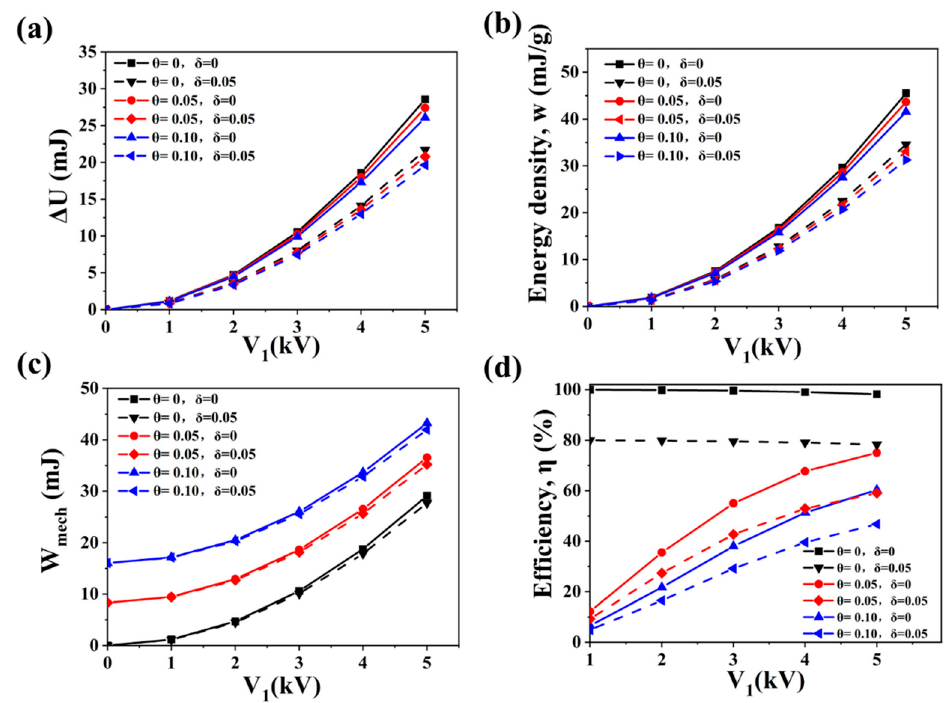
Figure 8. Influences of bias voltage V 1 , stress relaxation ratio θ and charge leakage ratio δ on the energy-harvesting performances of DE materials: ( a ) generated energy, ( b ) energy density, ( c ) input mechanical work, ( d ) electromechanical conversion efficiency. The abscissa represents the bias voltage; the black, blue and red curves represent the θ = 0, 0.05, 0.1, respectively; and the solid line and the dashed line represent the δ = 0 and 0.05, respectively.